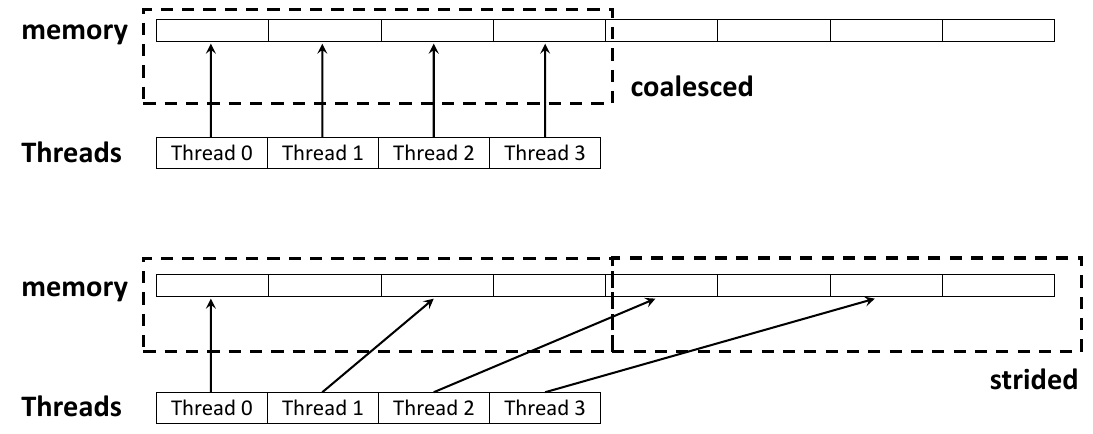
Figure 7. Memory coalesced and